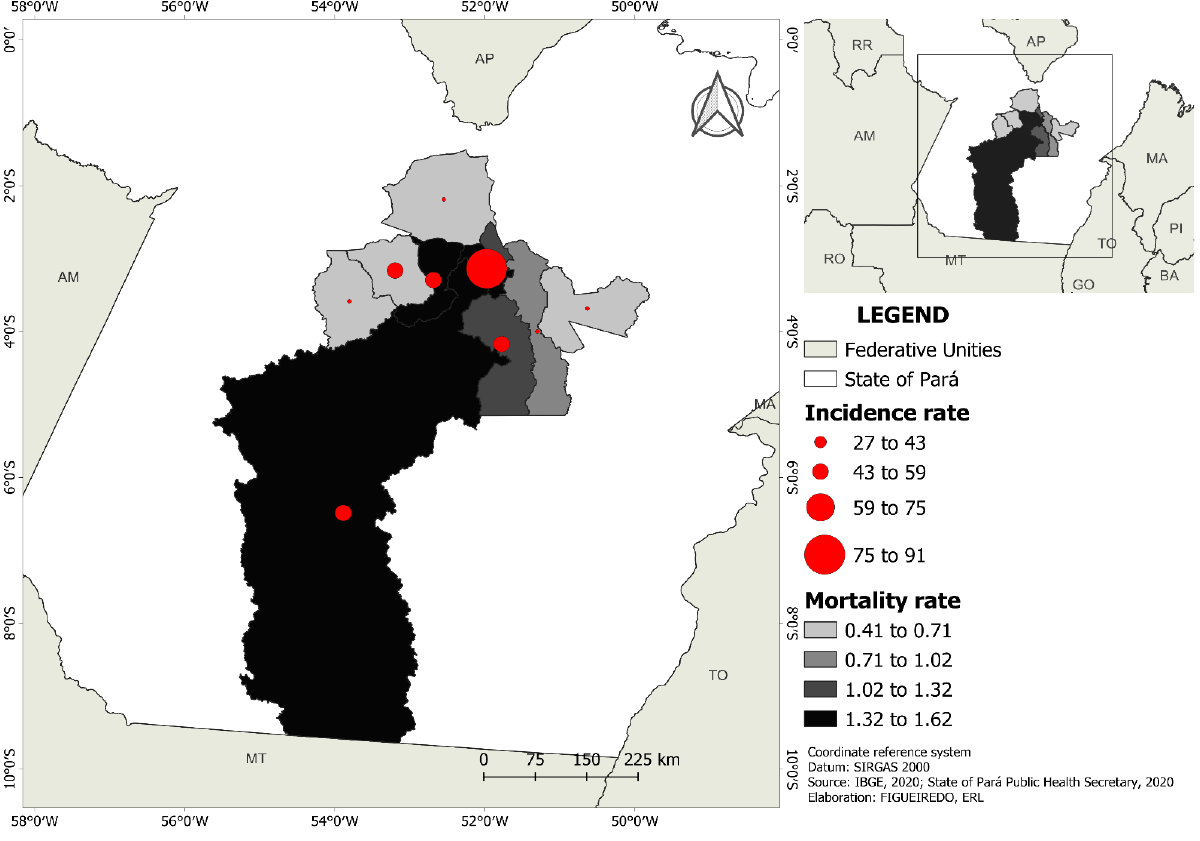
Figure 3. Incidence and mortality rate distribution per 1000 inhabitants of municipalities in the Xingu Health Region.